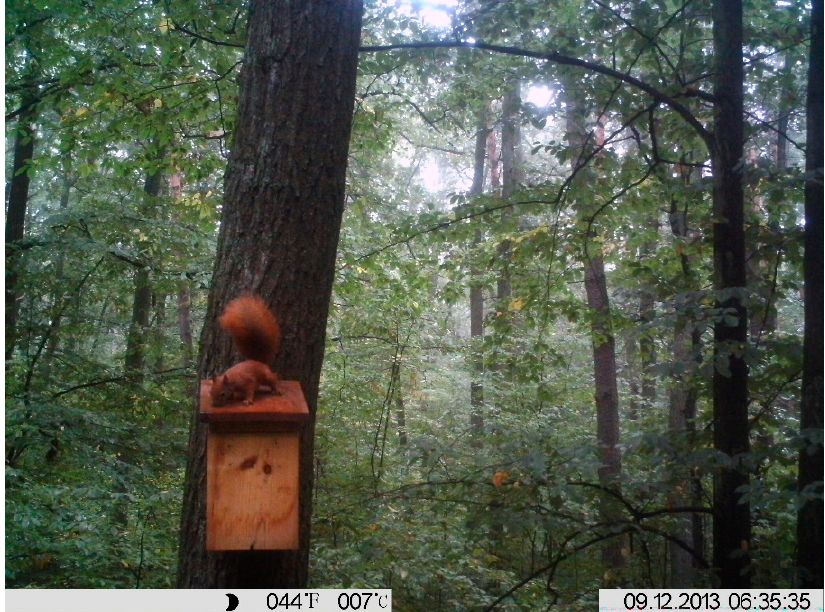
Figure A3. A red squirrel on nest box dedicated to this species (a camera-trap-taken photo). The nest box was placed autumn 2013 in a habitat mosaic of central Poland (study area no. 2) and monitored by photo traps.